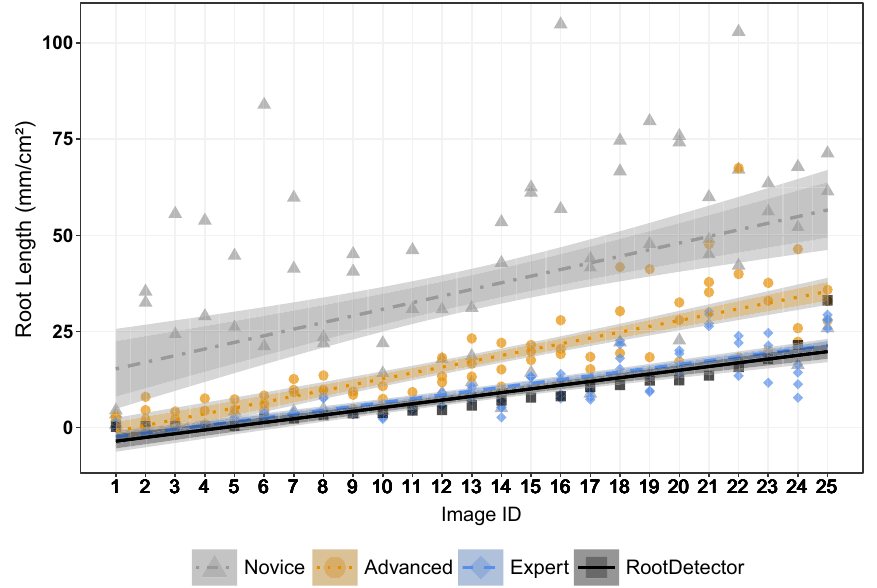
Figure 3. The CNN RootDetector performs as good as human experts (analysts with scientific background in root ecology and > 250 h experience in annotating roots), as indicated by the linear regression of RootDetector lying within the 95% CI (darker shaded ribbons) of the expert group. Groups of human analysts differ in their estimation of root lengths, as indicated by non-overlapping 83% CIs (lighter shaded ribbons). Novices had theoretical input on root ecology but no experience with minirhizotron images, advanced analysts had theoretical input on root ecology and > 100 h of experience with annotating minirhizotron images. Images are sorted by increasing root length according to RootDetector along the x-axis. The regression coefficient was 0.23 for the novice group; 0.67 for the advanced group, 0.74 for the expert group and 0.82 for